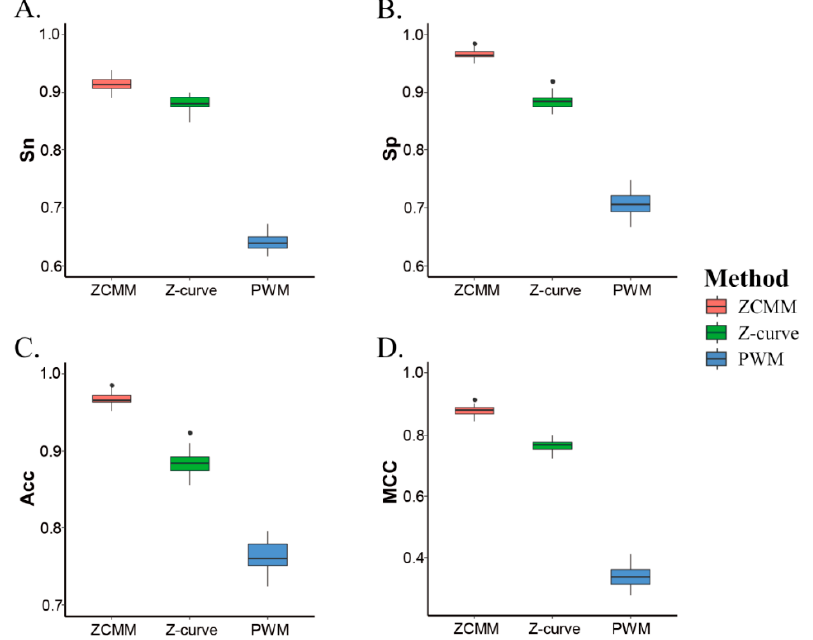
Figure 2. Comparison of four performances of three models for prediction results by 10-fold cross validation of support vector machine (SVM). ( A) , ( B ), ( C ), and ( D ) represent Sn , Sp , Acc , and MCC , respectively.